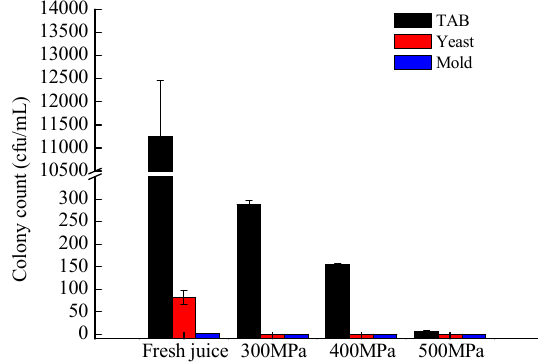
Figure 1. Changes in total aerobic bacteria (TAB), yeast and mold counts of fresh yacon-litchi-longan (YLL) juice as treated by high hydrostatic pressure (HHP) (300 MPa, 15 min), HHP (400 MPa, 15 min) and HHP (500 MPa, 15